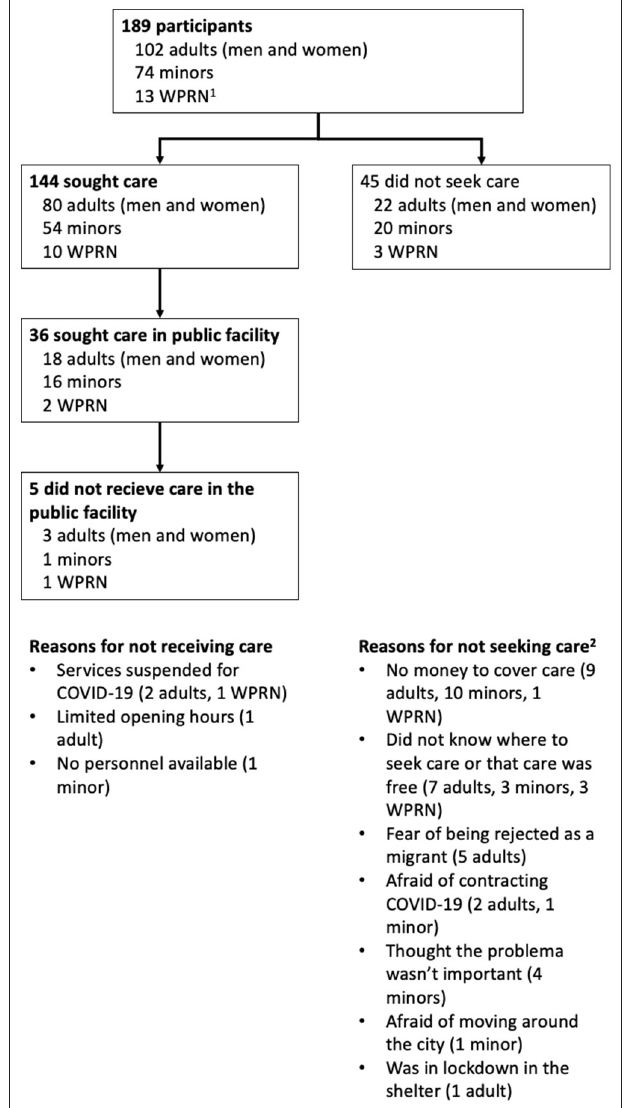
FIGURE 1 | Health care seeking by migrants who responded the quantitative survey. 1 WPRN: Women with a pregnancy-related need, responding questions on an additional, unrelated health need. 2 Responses to this question were not mutually exclusive. For minors, the reason was given by the adult in charge of